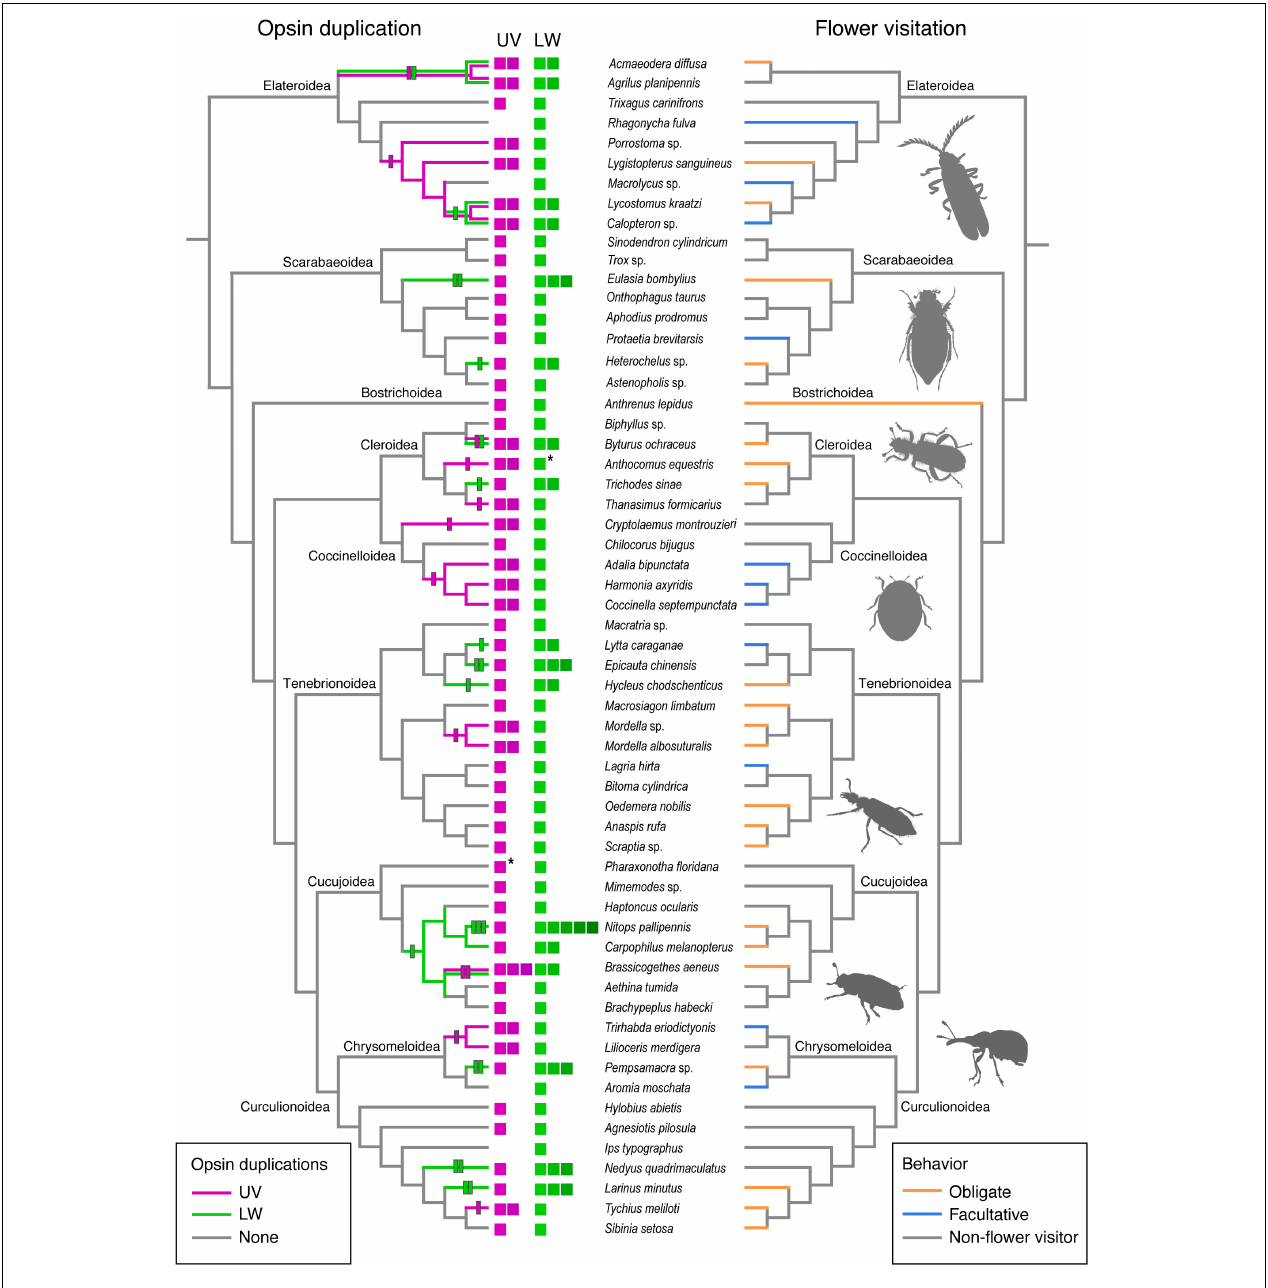
FIGURE 2 | Patterns of opsin duplication and flower-visitation behavior for 59 beetle species. The cladograms represent a simplified version of beetle relationships after McKenna et al. (2019) with the position of superfamilies indicated. The left-hand cladogram shows opsin duplication events with opsin copy number at the terminals and duplication events indicated on the branches. Duplication events were estimated using the opsin tree (see Supplementary Figure 2 ). Asterisks (*) denote cases where additional duplication copies were found but determined not to be functionally distinct (see Opsin Search Methods text). The right-hand cladogram reflects known behavioral categories for the level of flower visitation. No attempt at ancestral reconstruction was made due to the available taxon